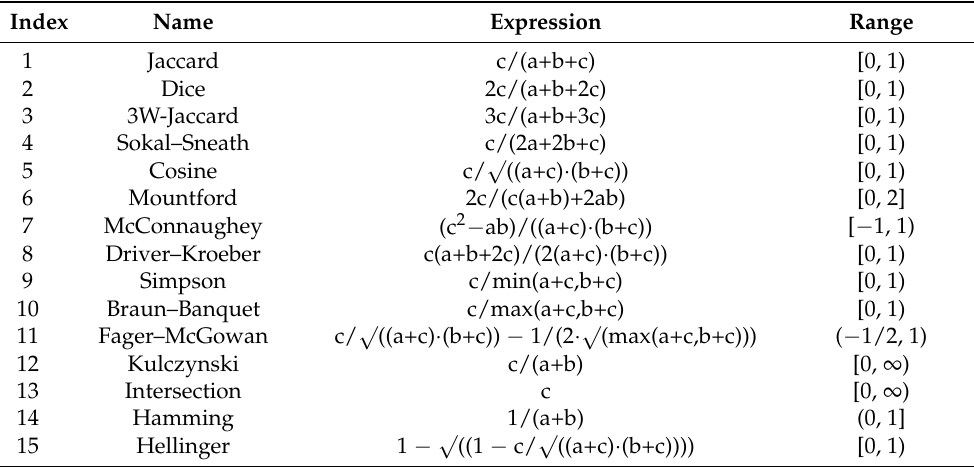
Table 4. List of all 15 binary asymmetric similarity